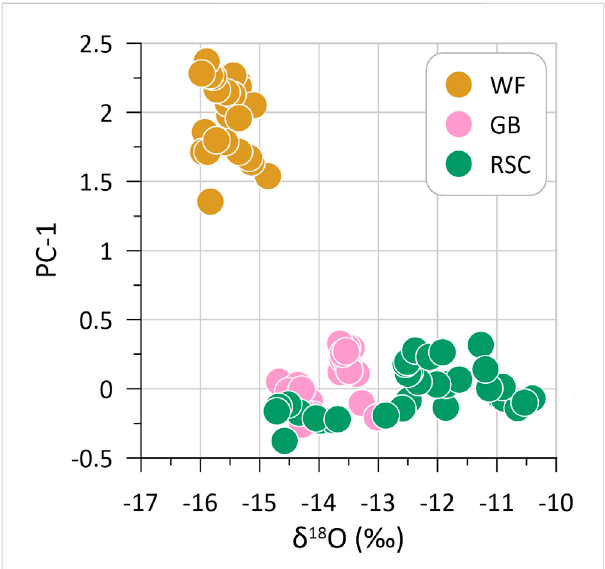
FIGURE 10 Biplot of δ 18 O and PC-1 for the three water samplers in the La Sal Mountains emphasizing the degree to which water at GB resembles rock glacier water at RSC, and the divergence of non-rock glacier in fl uenced water at